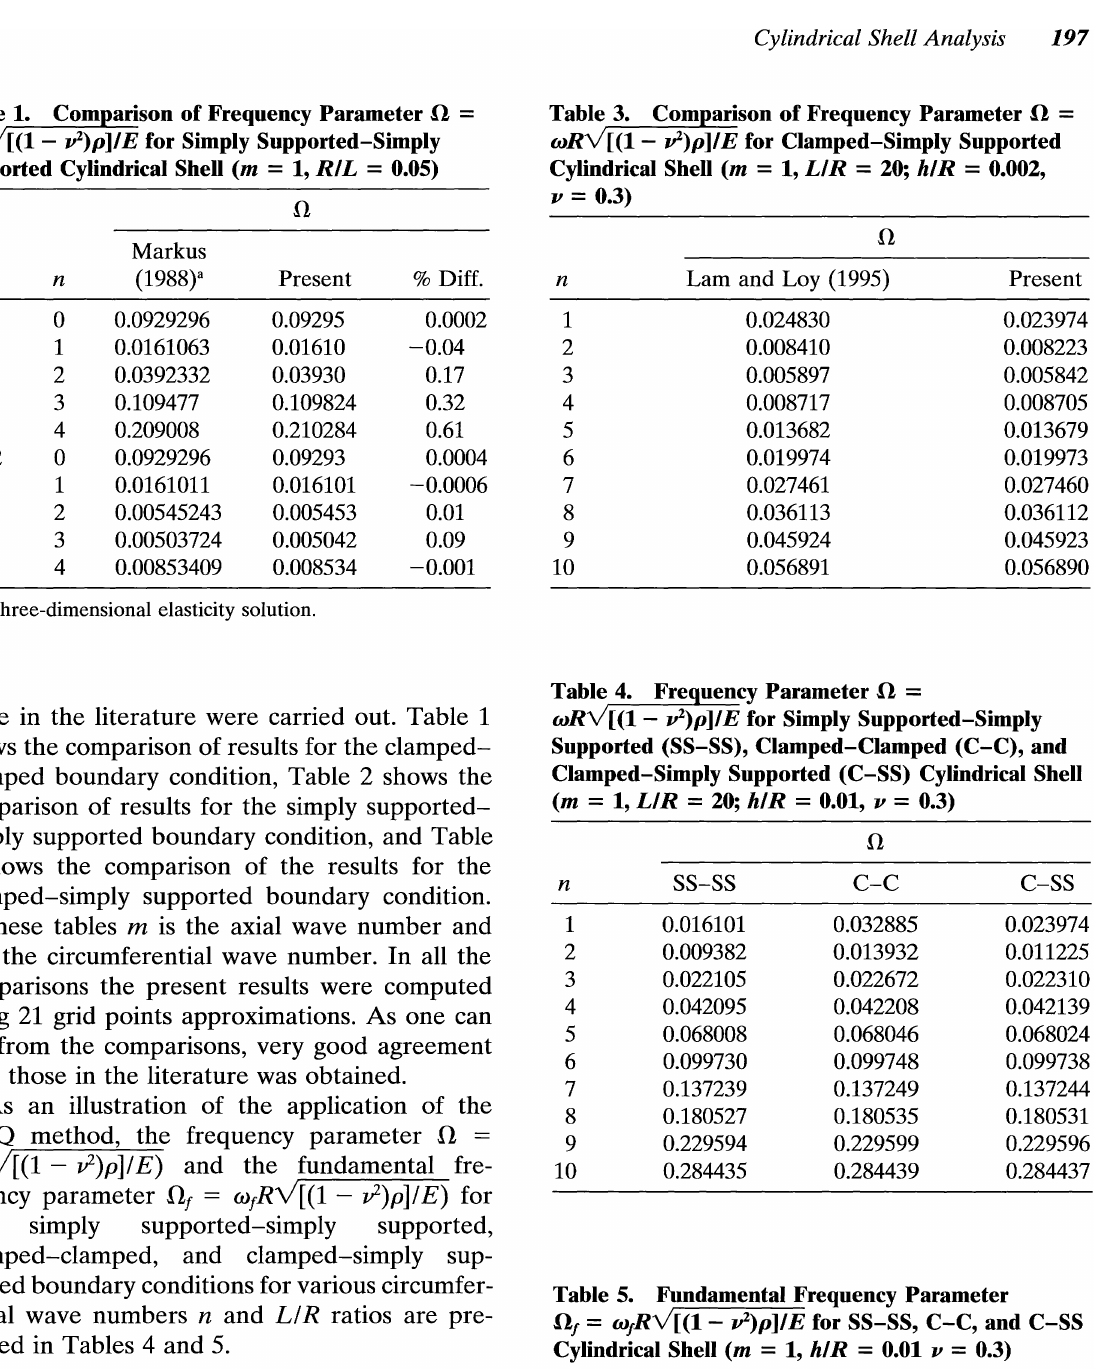
Table S. Fundamental Frequency